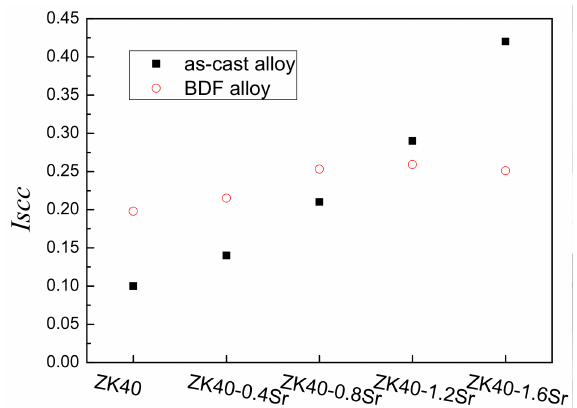
Figure 7. The comparison of the I SCC of the as-cast and BDF ZK40-xSr alloys.